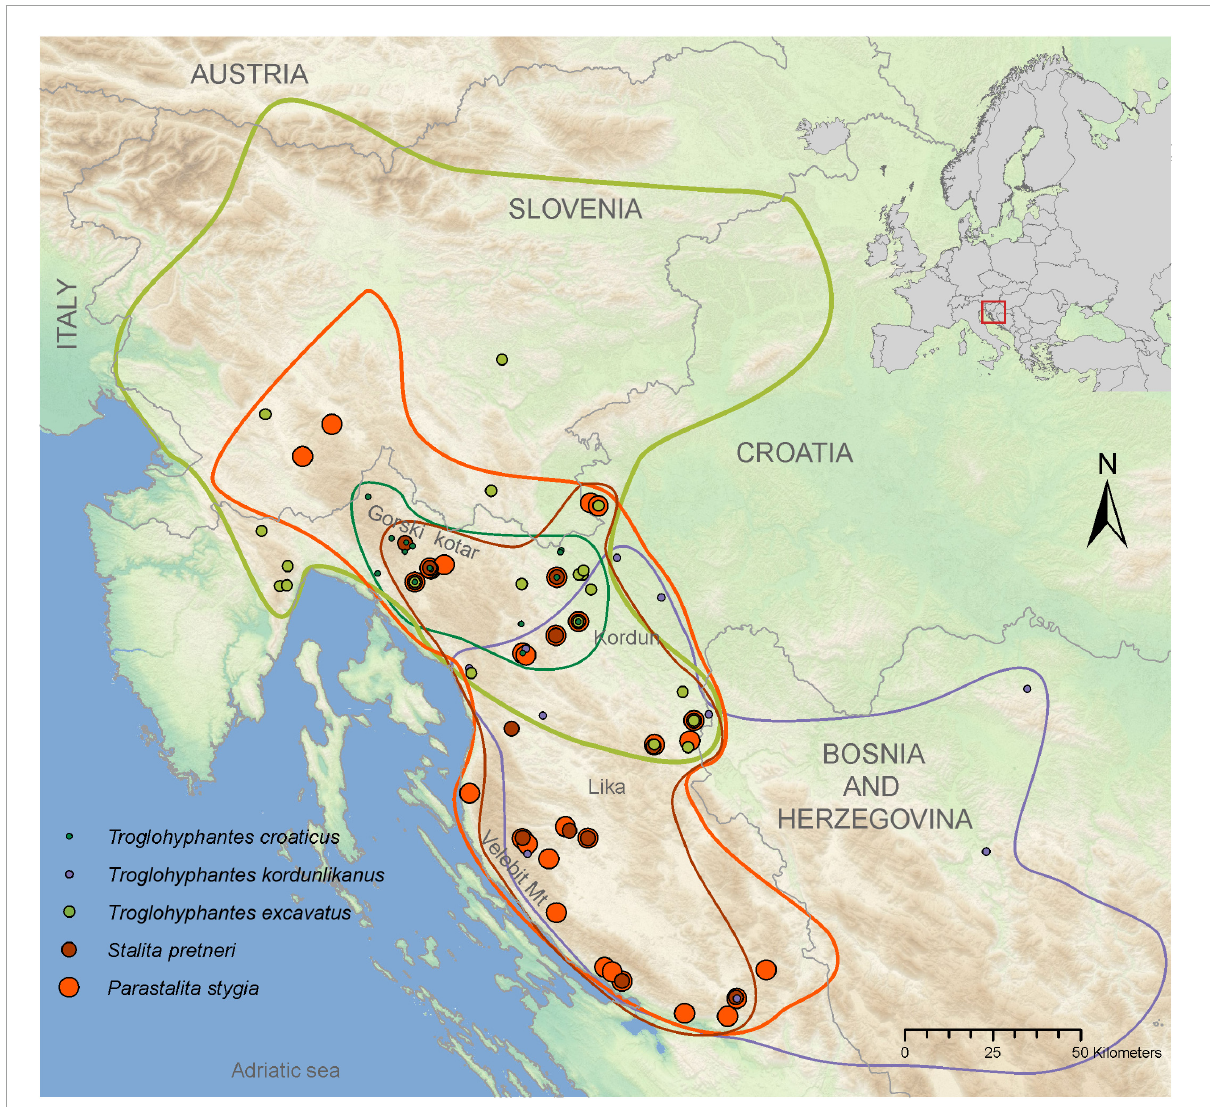
FIGURE2 Map showing the distributions of each of the five studied species. Dots represent the localities from specimens used in this study, and lines in matching colors encircle the species’ distributions. Overlapping dots represent caves with more than one species. Changes in dot sizes are used as a means of showing overlapping species